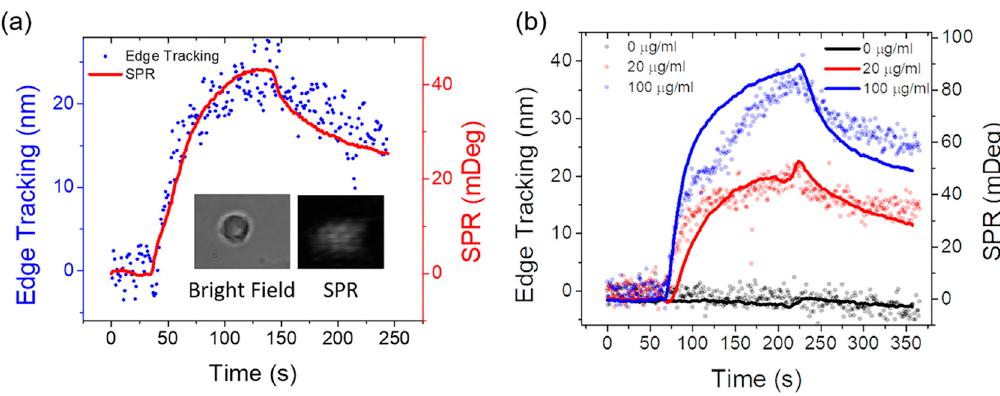
Figure 2. Comparison of both images and kinetic response curves measured by simultaneous edge tracking and SPR imaging on a single cell. ( a ) Simultaneously recorded edge tracking (blue) and SPR (red) response curve of 20 µg/mL wheat germ agglutinin (WGA) binding to an SH-EP α 4 β 2 cell (Inset: bright field (left) and SPR (right) images of the cell). ( b ) Averaged binding response curves of different concentrations of WGA binding to the cells on the chip from the two methods. The solid lines represent SPR results, and the dots represent the edge tracking results.